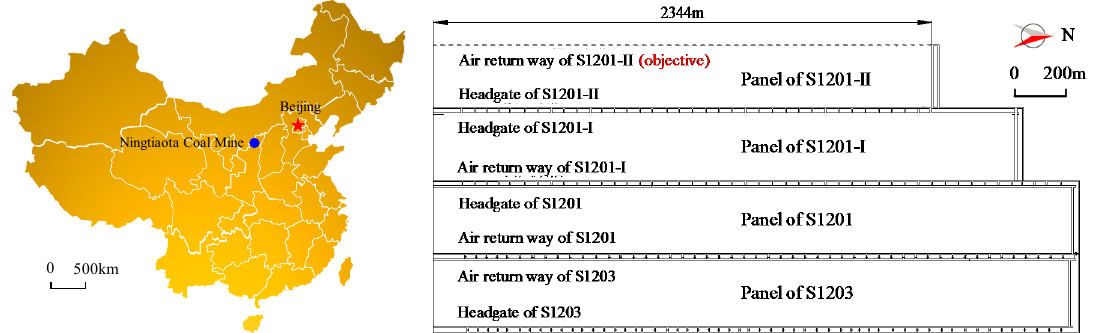
Figure 12. Layout of S1201-II working face and gateroads.